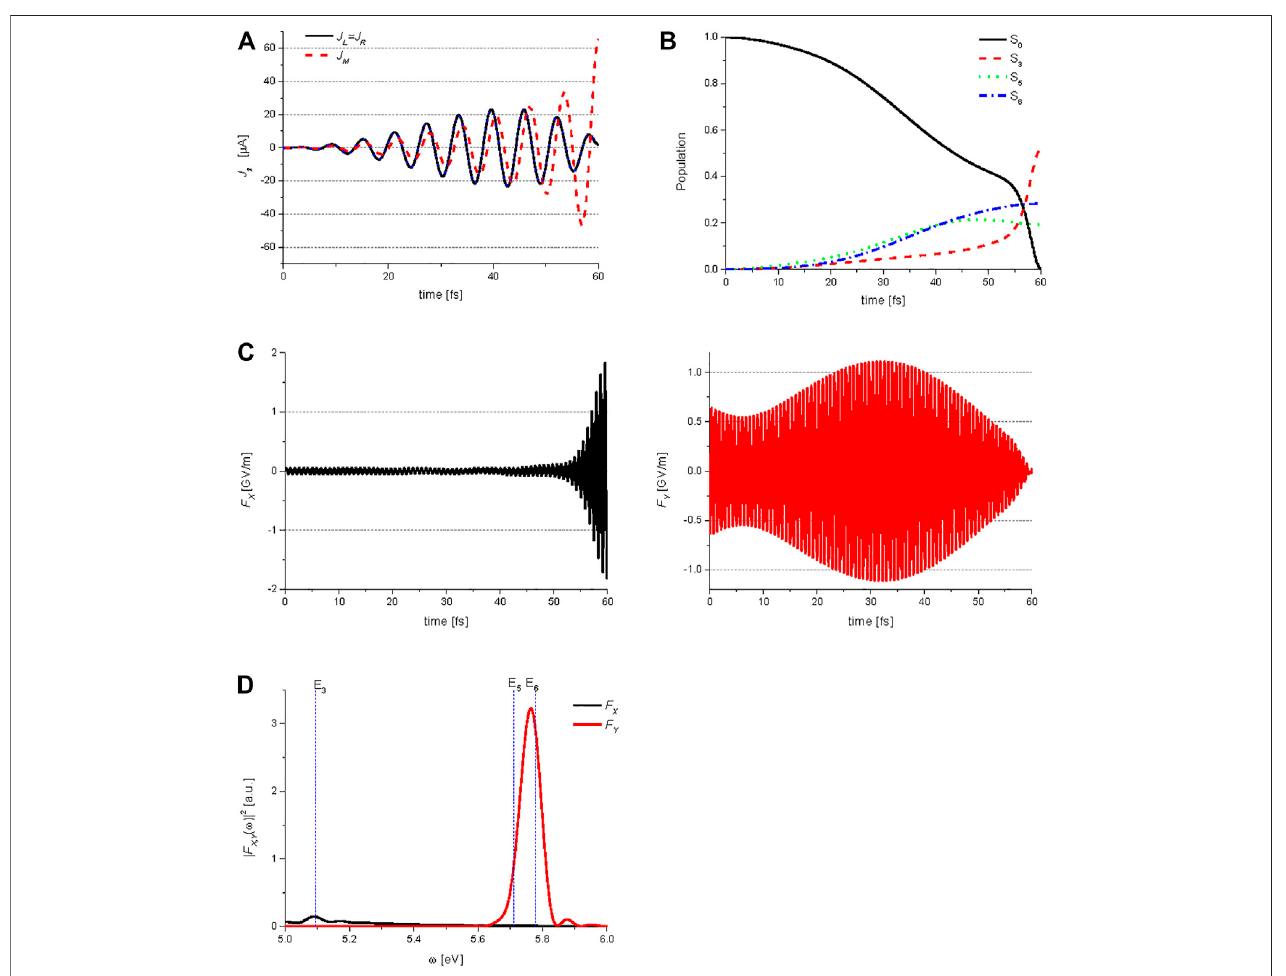
FIGURE 9 | Quantum optimal control simulations for generation of the middle ring current in anthracene: (A) temporal behavior of the ring currents J L ( t ) (cid:2) J R ( t ) (solidline)and J M ( t ) (broken line); (B) temporal behaviorofthe S 0 population and those ofthethree excitedstate S 3 (B 2u ),S 5 (B 2u ) and S 6 (B 2u ) populations; (C) optimized X -and Y -polarizedlaserpulse fi elds F X ( t ) (left-handside) and F Y ( t ) (right-handside) ; (D) Fouriertransformedspectraofthelaserpulse fi elds F X ( ω )and F Y ( ω ).Reprinted with permission from Ref. [42] Copyright (2017) American Institute of